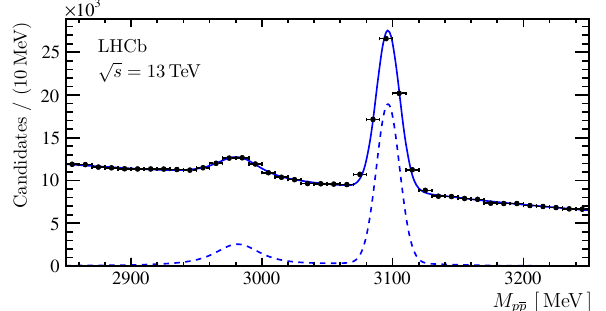
Fig. 5 Distribution of the pp invariant mass. The solid line represents the fit result, while the dashed line shows the η c and J /ψ signal contri- butions Table 4 Systematic uncertainties on the measurement of the J /ψ – η